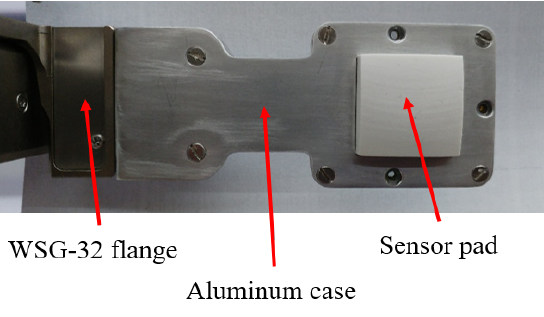
Figure 7. Picture of the sensorized finger fully integrated with the WSG-32 gripper.